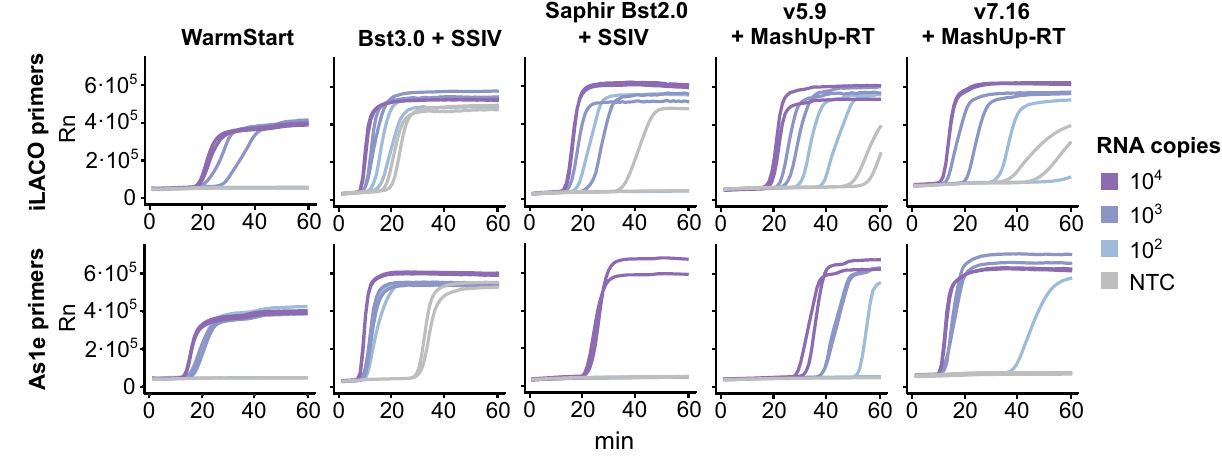
Figure 3. Benchmarking of in-house produced enzymes against commercial alternatives. Synthetic RNA templates (iLACO and As1e) amplified with the corresponding primers and either WarmStart, Bst3.0 with SSIV, Saphir Bst2.0 Turbo with SSIV, v5.9 with MashUp-RT, or v7.16 with MashUp-RT (same conditions for v5.9 and v7.16 as in Fig. 2B). All experiments were run for 1 h at 65 °C in a thermocycler, tracked by Eva Green